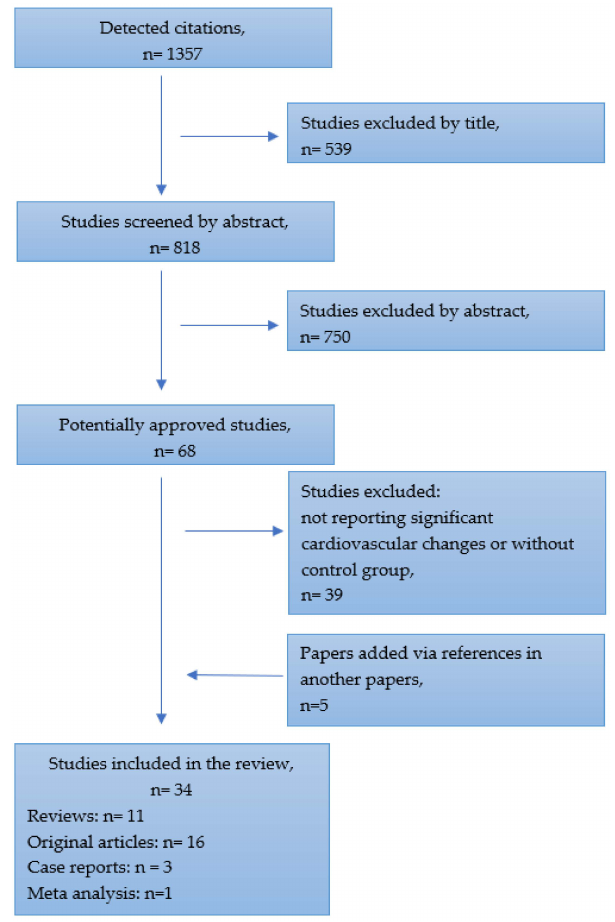
Figure 1. Flow chart for selecting